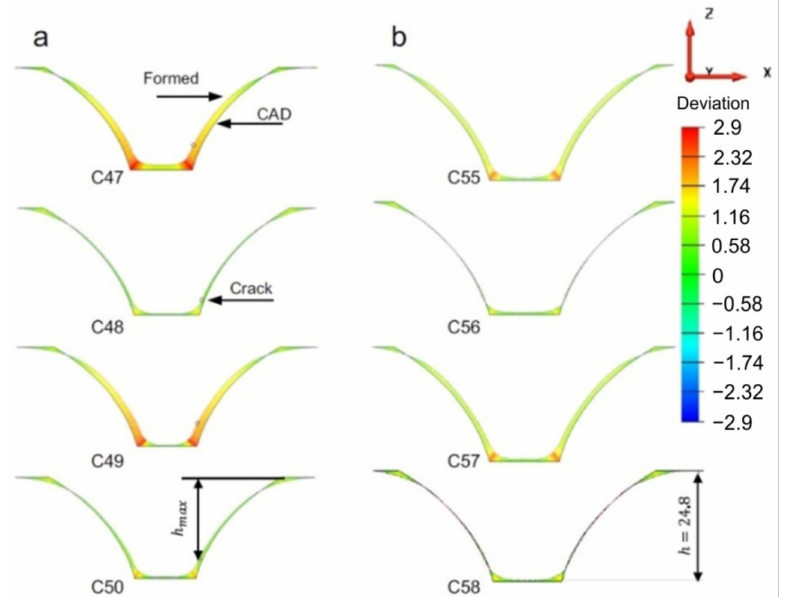
Figure 17. Deviation of the cross-sectional profiles with ( a ) climbing rotation and ( b ) conventional rotation at different heights in the part (reproduced with permission from [96]; copyright © 2018, The Author(s); this is an open-access article distributed under the terms of the Creative Commons CC BY license, which permits unrestricted use, distribution and reproduction in any medium, provided the original work is properly